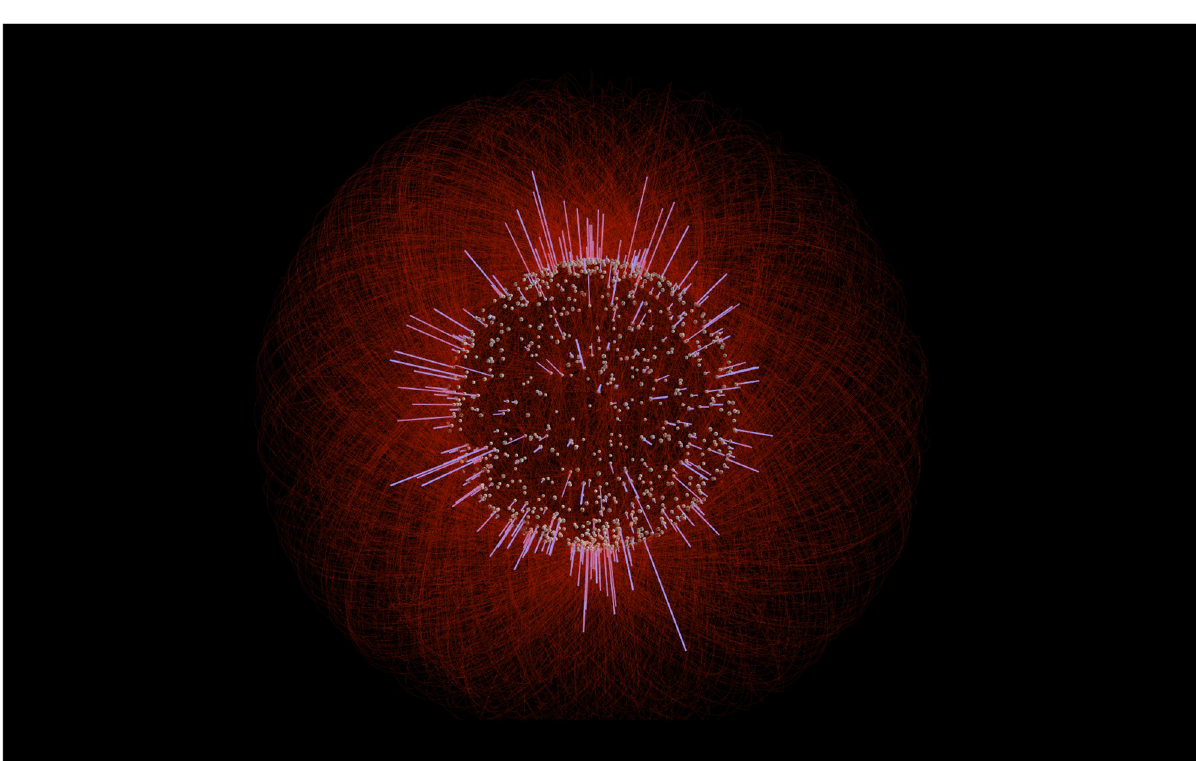
Fig 6. Worldwide airline routes. Nodes correspond to airports, links correspond to flight routes. Only the 1000 most conencted nodes are shown for the sake of simplicity. Data available from openflights.org/data.html. The network has been visualized with Vizaj using a Circle shape for the links.